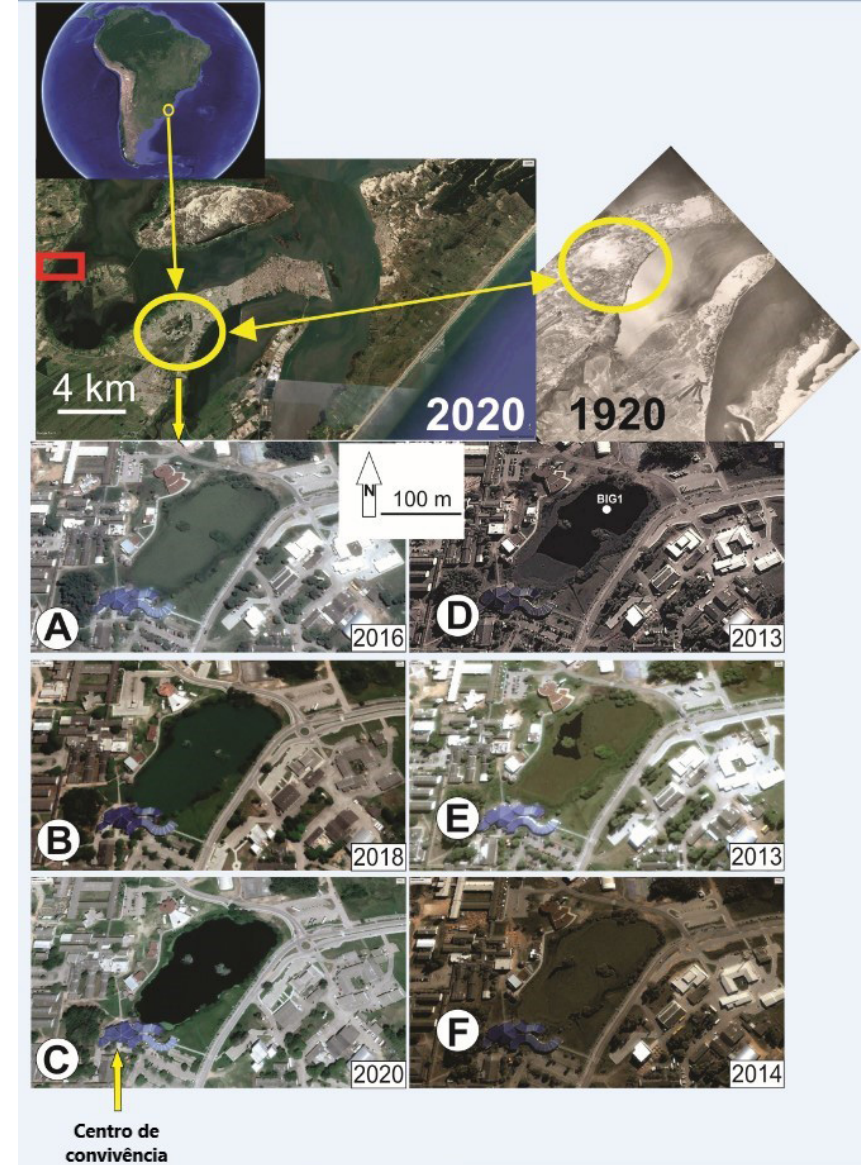
Figure 1. Upper panels show an overview of the city of Rio Grande, indicating the position of the university campus with a yellow circle for both 2020 and 1920. The red box shows the location where the organic matter isotopic was survey carried out by Patterson (2016). (A), (B) and (C) show examples from Lake Biguás under a limnological phase dominated by phytoplankton, while (D), (E) and (F) show examples of a limnological phase dominated by macrophytes under three conditions of macrophyte proliferation. Aerial photographs from Google